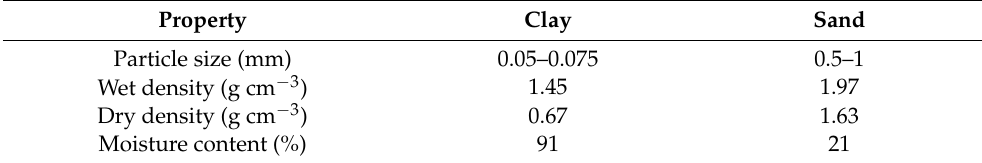
Table 1. The characteristics of clay and sand.